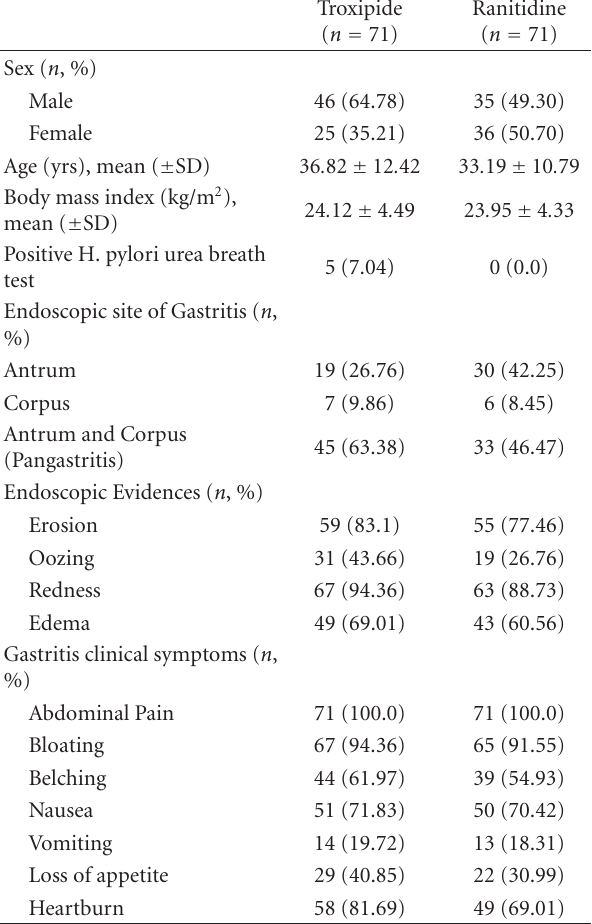
Table 1: Baseline demographic and clinical characteristics of study